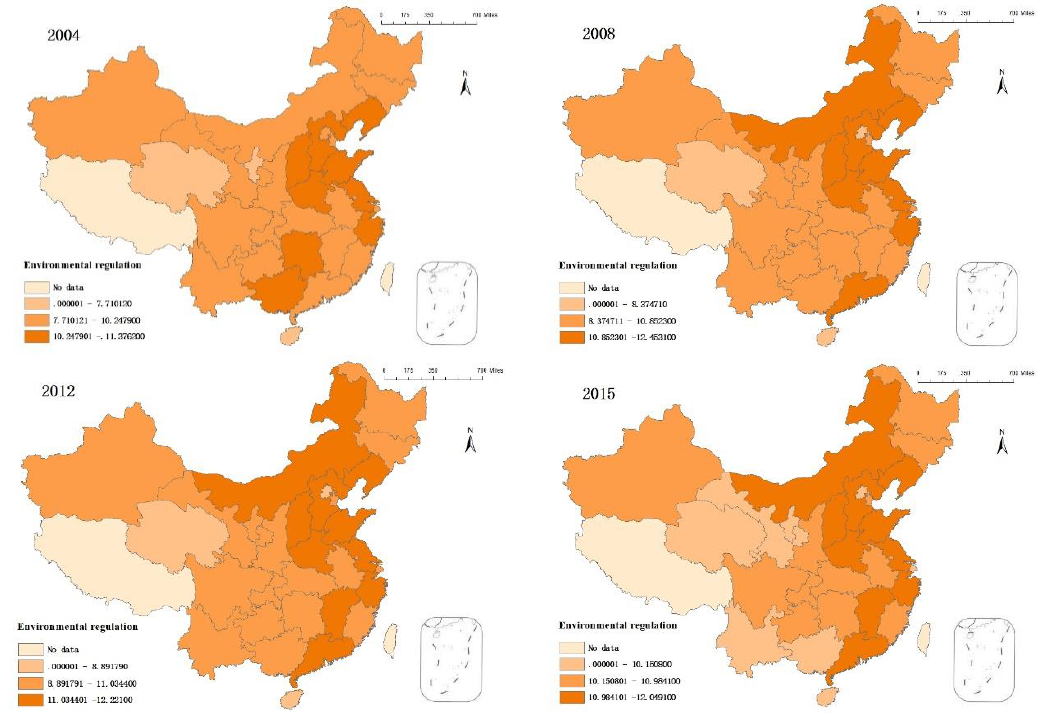
Figure 3. The temporal and spatial evolution of Chinese environmental regulations.